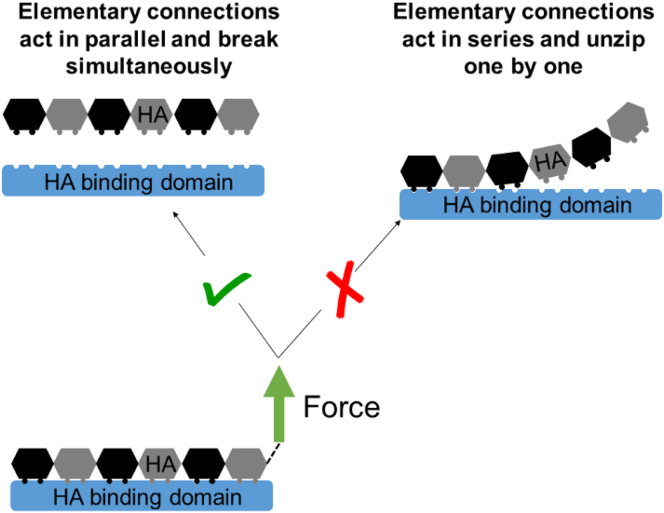
Schematic illustration of possible scenarios for breaking HA⋅hyaladherin bonds. The correlation of rupture force with bond length suggests that the elementary connections that constitute a bond act in parallel and break simultaneously, rather than in a zipper-like fashion. To see this figure in color, go online.